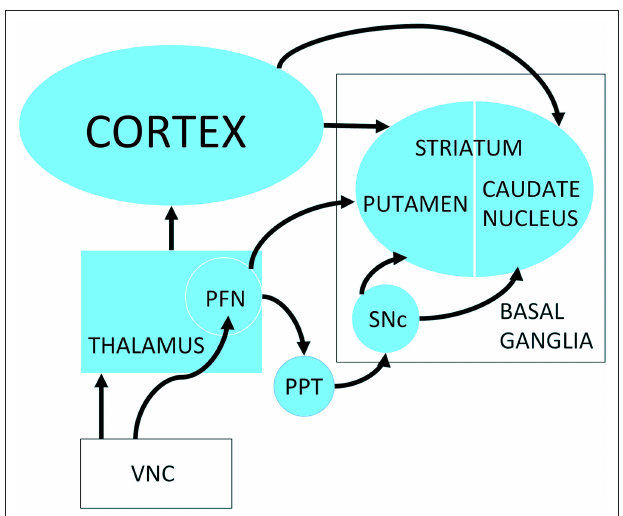
FIGURE 1 | Possible neuronal pathways connecting the vestibular nucleus complex to the striatum. PFN, Parafascicular nucleus; PPT, pedunculopontine tegmental nucleus; SNc, Substantia nigra pars compacta; VNC, vestibular nucleus complex. Reproduced from Stiles et al. ( 59) with permission from the publisher.